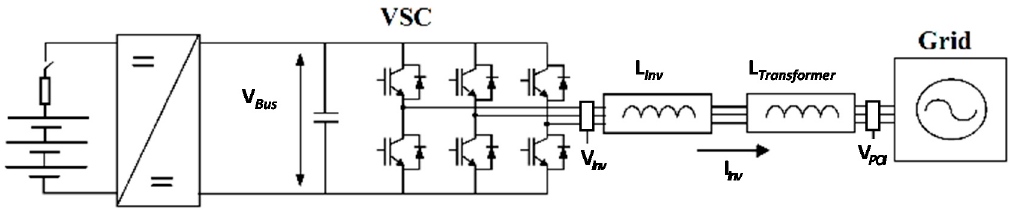
Figure 1. Power conversion system configuration. V Bus represents the dc-link voltage, V Inv is the converter voltage, V POI is the connection point voltage and I Inv is the converter current. L Inv is the equivalent converter filter inductance and L Transformer is the short-circuit inductance of the grid connection transformer. VSC is the voltage source converter.